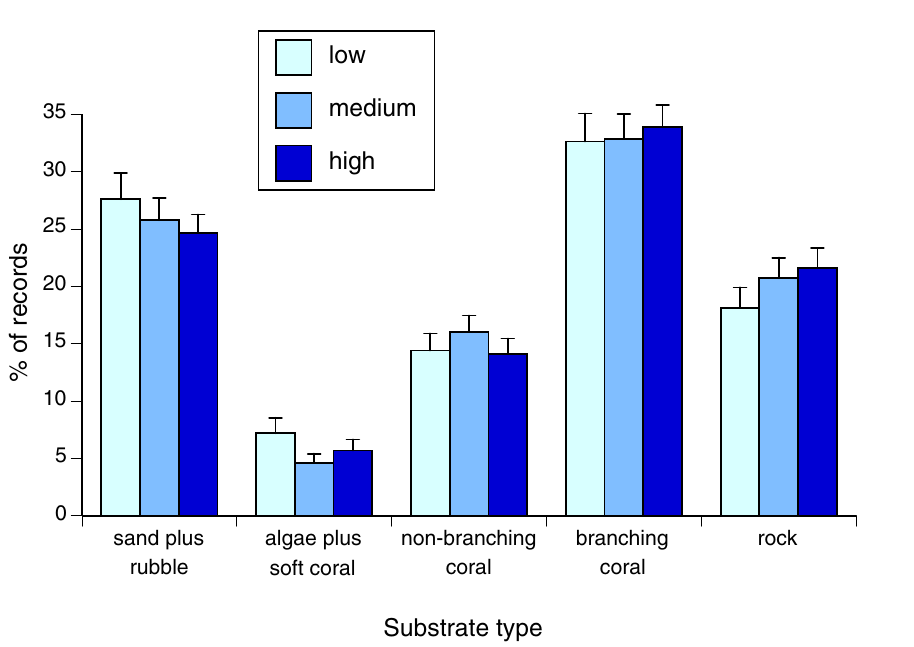
Figure 2. Effect of tidal phase on the habitat (substrate) types in sites where we found sea snakes ( Emydocephalus annulatus ) in the Baie des Citrons, New Caledonia. Bars show SEs.